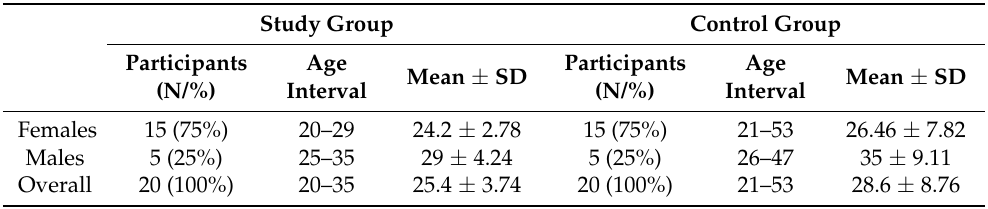
Table 1. Demographic characteristics of the two groups.